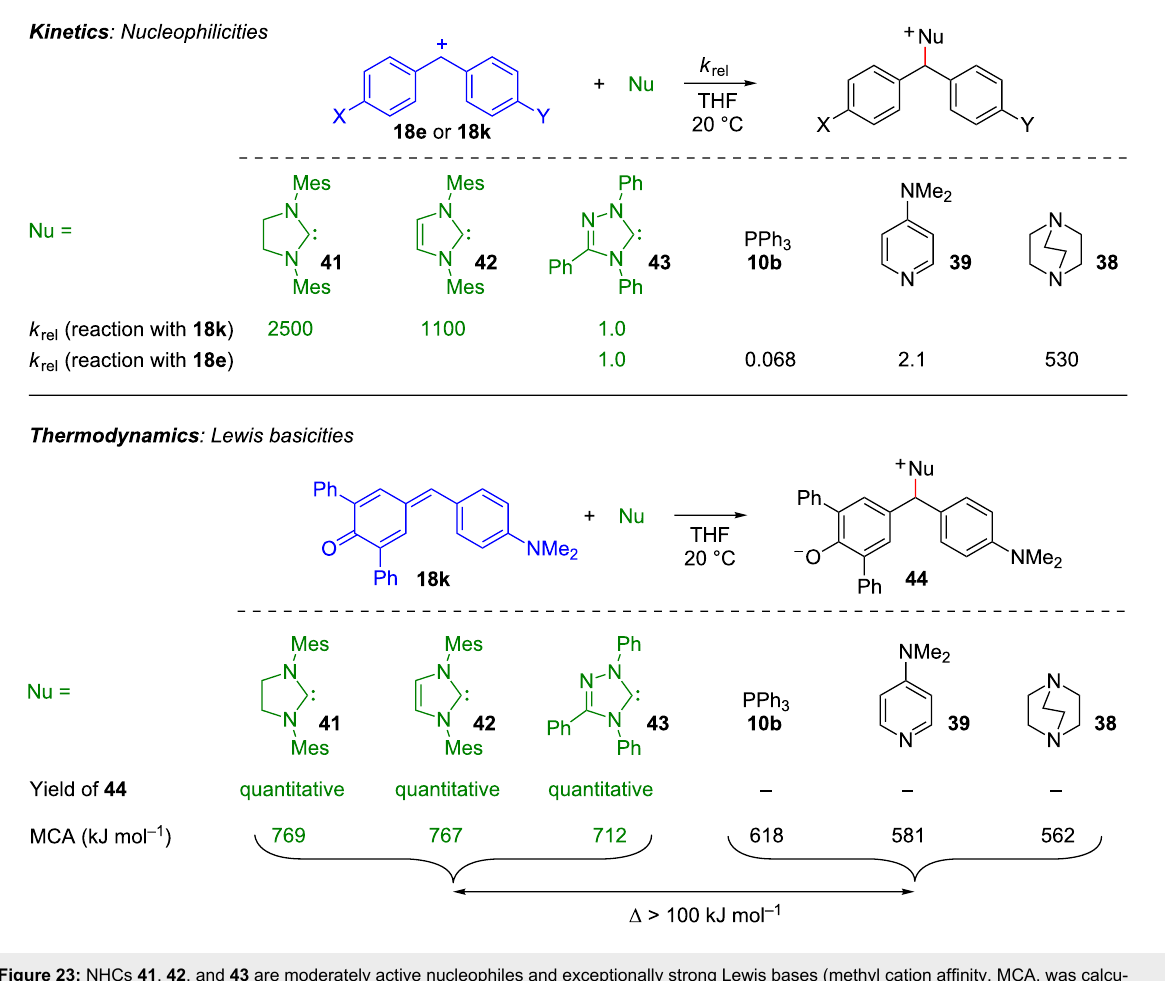
Figure 23: NHCs 41 , 42 , and 43 are moderately active nucleophiles and exceptionally strong Lewis bases (methyl cation affinity, MCA, was calcu- lated for the reaction CH 3+ + Nu → CH 3 –Nu + on MP2/6-31+G(d,p)//B98/6-31G(d) level of theory)